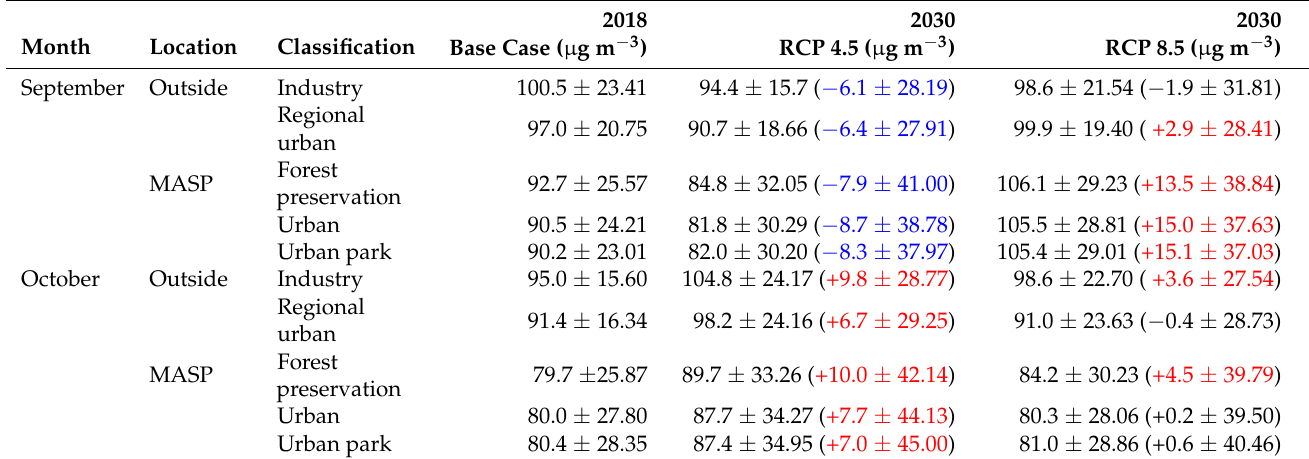
Table 3. Mean ± standard deviation of surface MDA8 O 3 over São Paulo by station type.